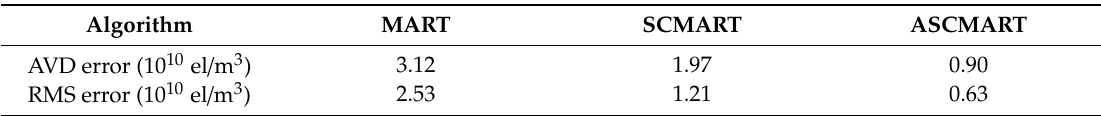
Table 3. Tomographic error statistics of the MART, SCMART, and ASCMART during geomagnetic storm days.